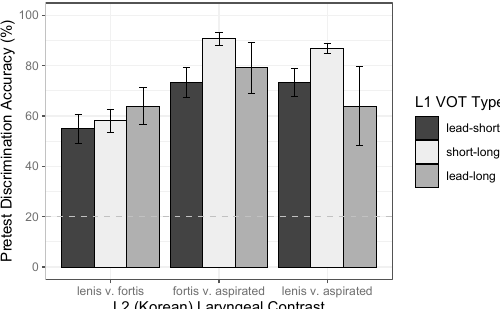
Figure 3. Pretest performance in the stop study (accuracy in oddball discrimination), by L2 laryngeal contrast and L1 group (i.e., VOT type). Error bars indicate SE of the mean over participants; the dotted line marks chance ‐ level performance (20%). Table 5. Fixed ‐ effect coefficients in the final model of pretest stop discrimination [ N = 2052, log ‐ likelihood = − 958.7]. Significance code: *** p < 0.001.